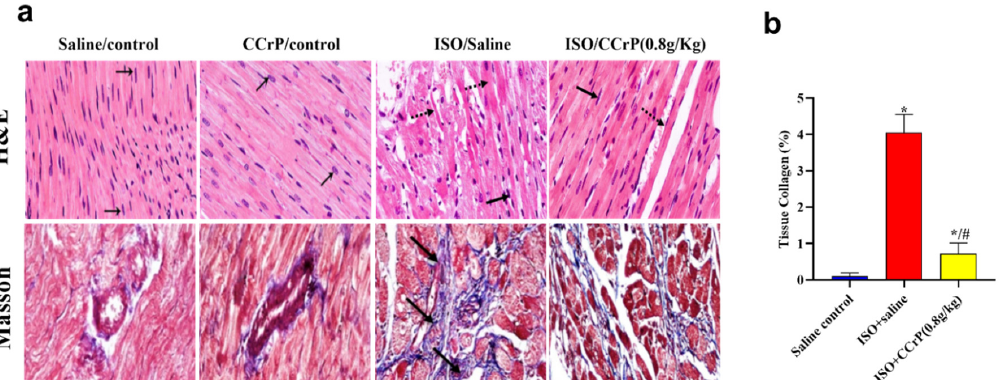
Figure 5. ( a ) Histopathological analysis of H&E (cardiac inflammation) and Masson’s trichrome- stained (cardiac fibrin and collagen deposition) heart sections related to the effect of different doses of CCrP on myocardial fibrosis associated with ISO administration (black arrows—area of fi brosis). Specimens stained with Masson’s trichrome for estimation of myocardial fi brosis (blue color) in saline/control, CCrP/control, ISO/saline, and ISO/CCrP rats at a dose of 0.8 g/kg/day. ( b ) ISO/CCrP rats at a dose of 0.8 g/kg showed an 83% reduction in collagen% compared to levels detected in the ISO/saline rats. Data are presented as mean ± S.E.M. (n = 5.) *: statistical signi fi cance ( p < 0.05) com- pared to the saline/control group. #: statistical signi fi cance ( p < 0.05) compared to the ISO + saline group. ISO: isoproterenol; CCrP: cyclocreatine phosphate.